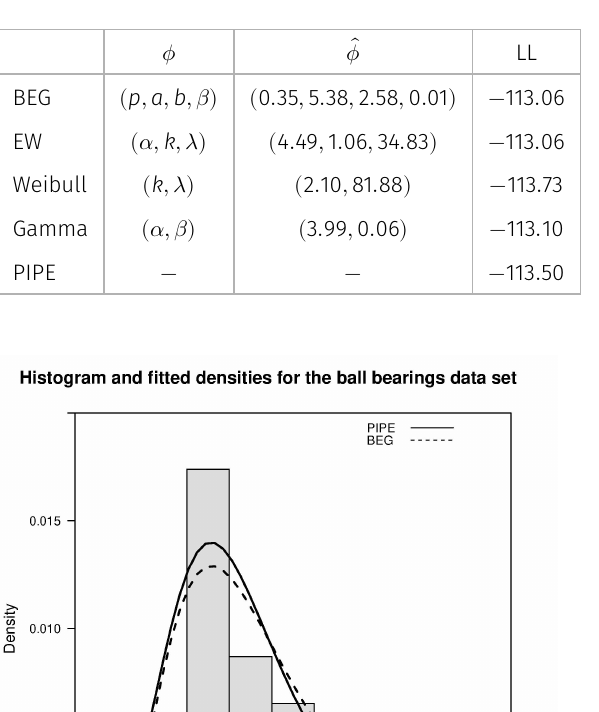
Table III. Estimation for the ball bearings data set.